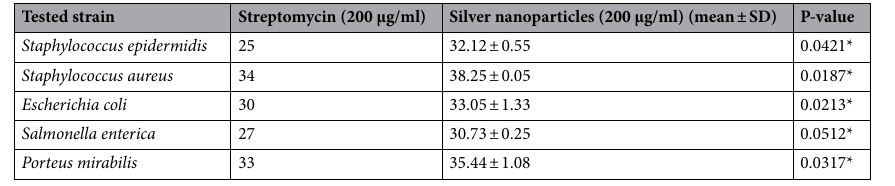
Table 5. Diameter in mm of zones of inhibition of biosynthesized silver nanoparticles against a standard antibacterial agent streptomycin by disc diffusion method. Data is mean of three replicates ± SD. *P-value significant ˂ 0.05.